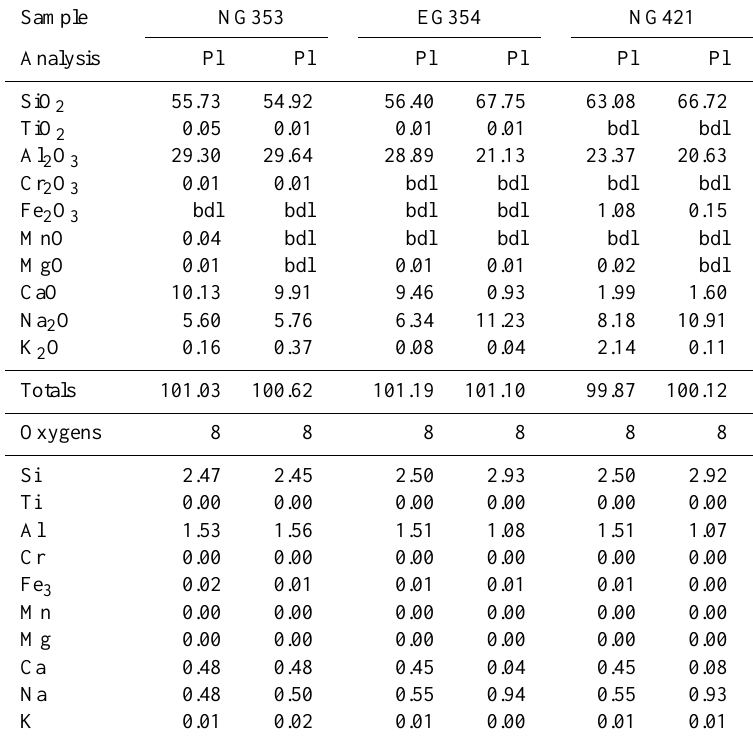
Table 4c. Representative EMPA analyses of Plagioclase.